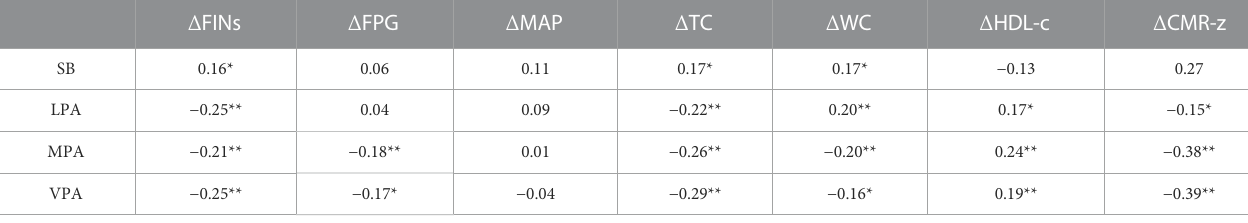
TABLE 4 Correlation between CMR factors changes with different intensities of physical activity and